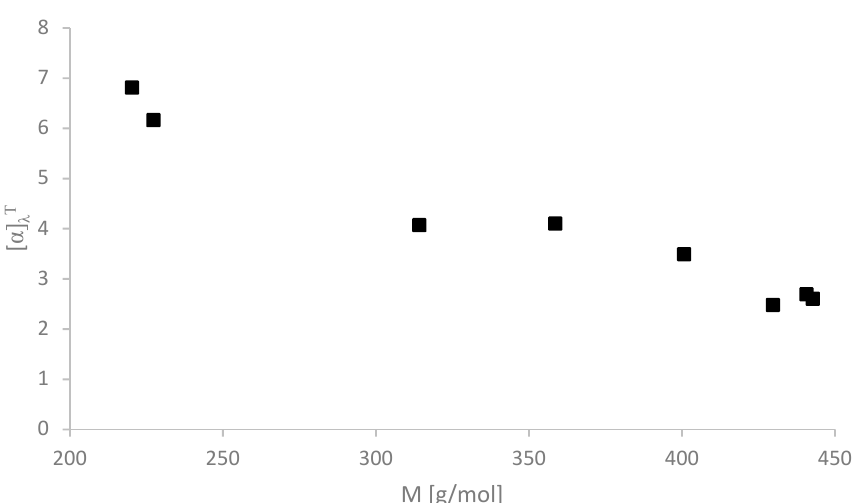
Figure 8. Plot of specific rotation ([ α ]) vs. molar mass for tetrabutylamonnium ionic liquids.